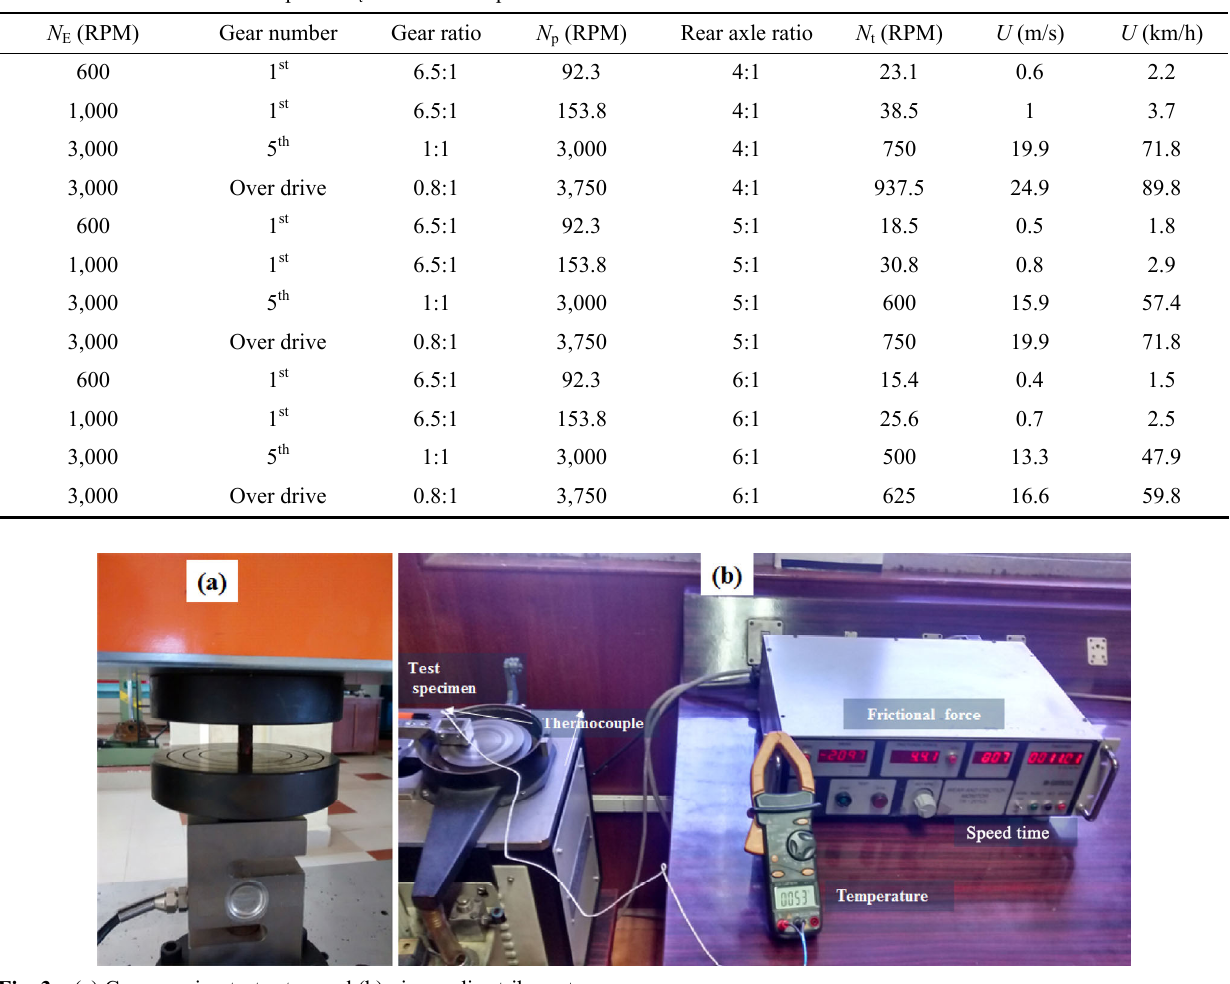
Fig. 3 (a) Compression test setup and (b) pin-on-disc